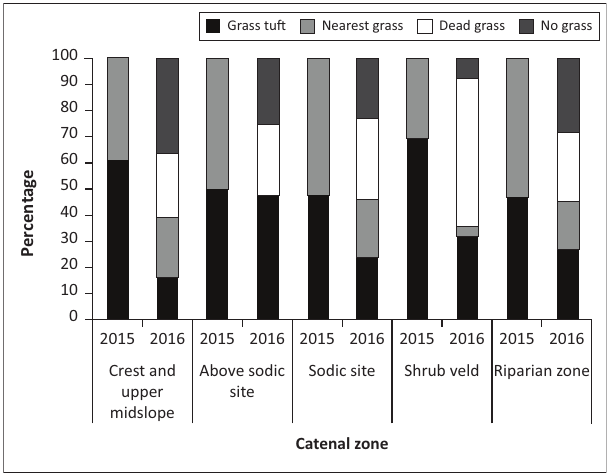
FIGURE 3: Comparison between two years of grass cover in the exact same locations in each catenal zone. It is based on point method data on a 100 m line transect. If the crown (base) or shoot of a grass tuft was touched by a metal rod, it was indicated as grass cover. If no tuft was touched by the rod, the nearest grass (30 cm radius) was noted, and if no living grass was within the radius, it was noted as bare soil or dead grass, respectively. No grass was noted as bare soil or dead grass, respectively. Forbs were not included.